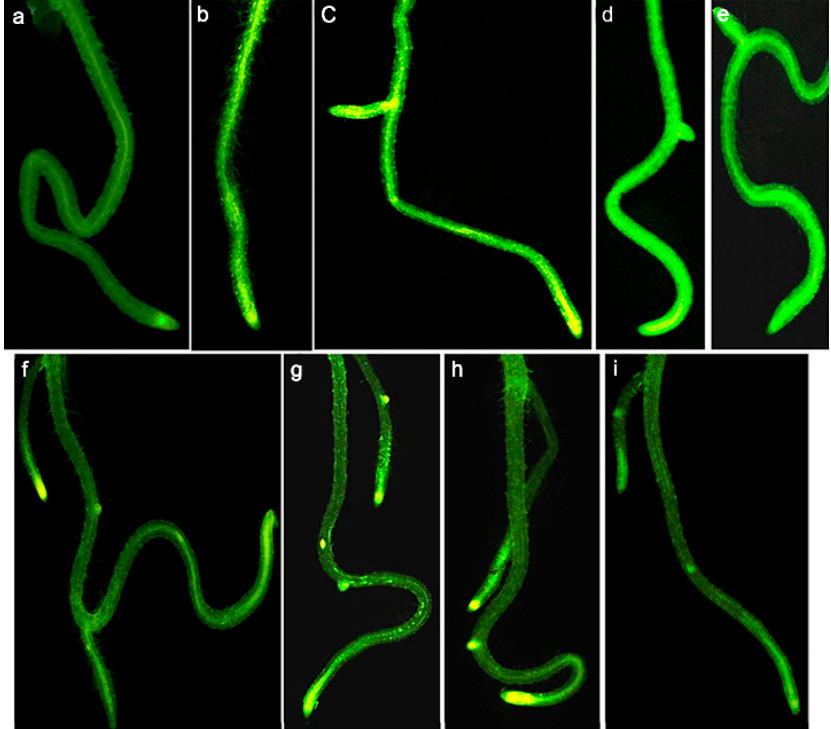
Figure 3. Accumulation of zinc in roots of A. thaliana seedlings evidenced by Zynpyr-1fluorescence after exposure to various concentrations of zinc and ZnO NPs. ( a ) Control and seedlings grown in the presence of 20, 50, 100 and 200 mg/L of ( b – e ) Zn and ( f – i ) ZnO NPs. Reprinted with permission from Ref. [36].